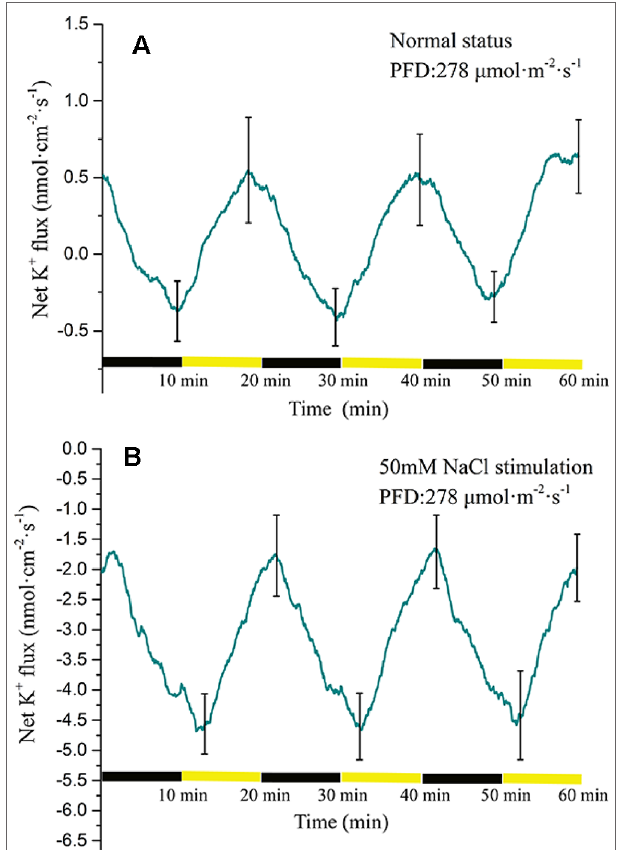
FIgURe 7 | Measurement of net K + flux before and after 50 mM NaCl stimulation. (a) Net K + flux induced by periodic illumination/darkness without NaCl treatment (normal condition). (B) Net K + flux induced by periodic illumination/darkness with 50 mM NaCl stimulation. The duration of net K + influx significantly increased after 50 mM NaCl stimulation. Negative values represent ion efflux. Note: wavelet decomposition was applied to the raw K + flux data to remove noise using the Daubechies (db4) wavelet transform, where wavelet layer number was 2–4. Mean ± SE ( n = 4); n—number of seedlings.